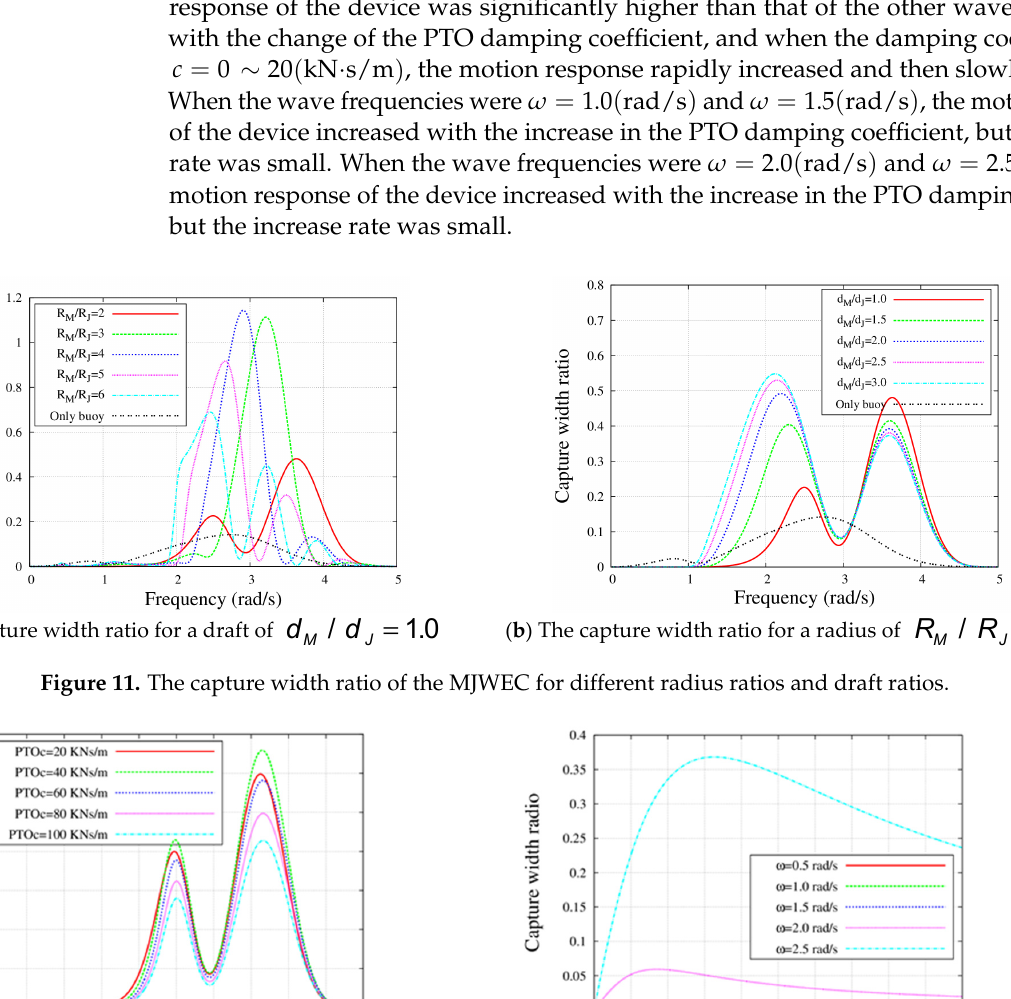
Figure 12. Effect of damping and frequency on the capture width ratio of the MJWEC.